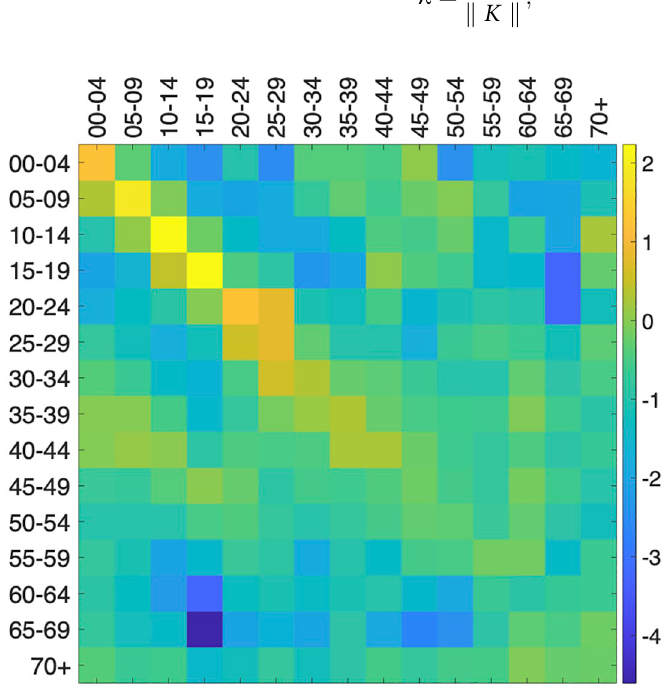
Fig 1. Elements of the matrix K of physical contacts among age classes in Italy (source: [57]). For the sake of readability, the colors of the cells corresponds to ln( K ij ).